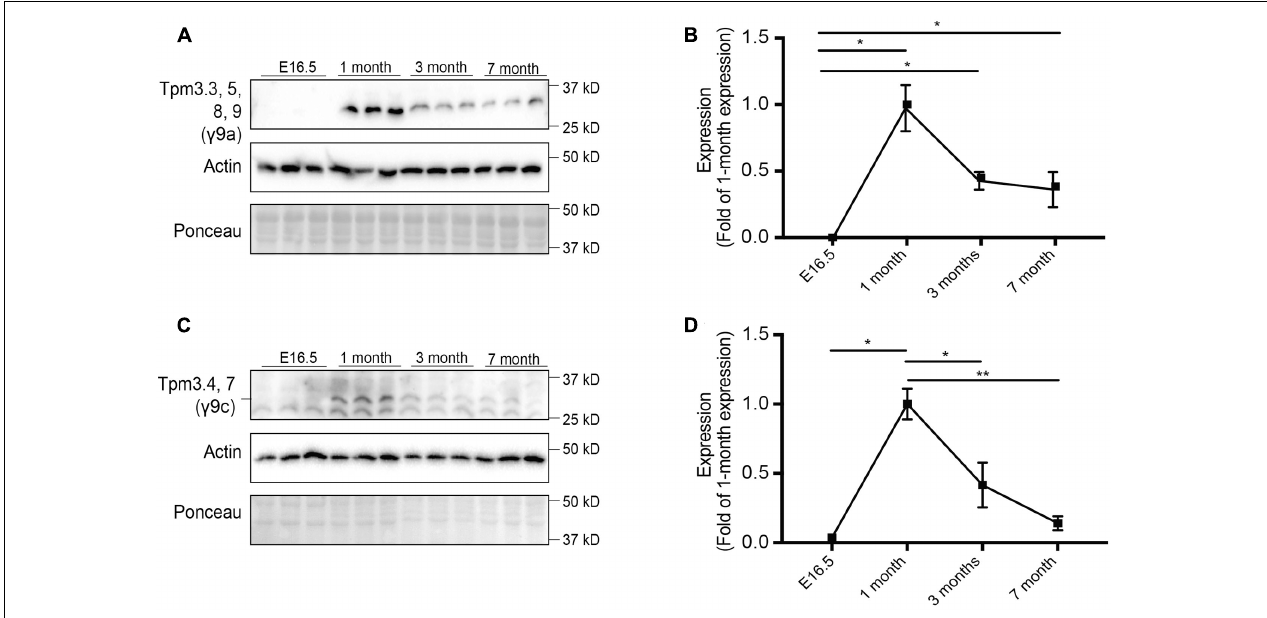
FIGURE 2 | Expression profile of tropomyosin (Tpm) isoforms in the brain throughout development and aging. Western blot analysis and quantification of E16.5, 1, 3, and 7-months old-mouse brain tissue for Tpm expression. (A) Tpm3.3, 5, 8, 9 expression as detected by the γ /9a antibody. (B) Quantification of (A) . (C) Expression of Tpm3.4,7, as detected by the γ 9c antibody. (D) Quantification of (C) . (mean ± SEM, n = 3, ∗ P < 0.05, ∗∗ P <